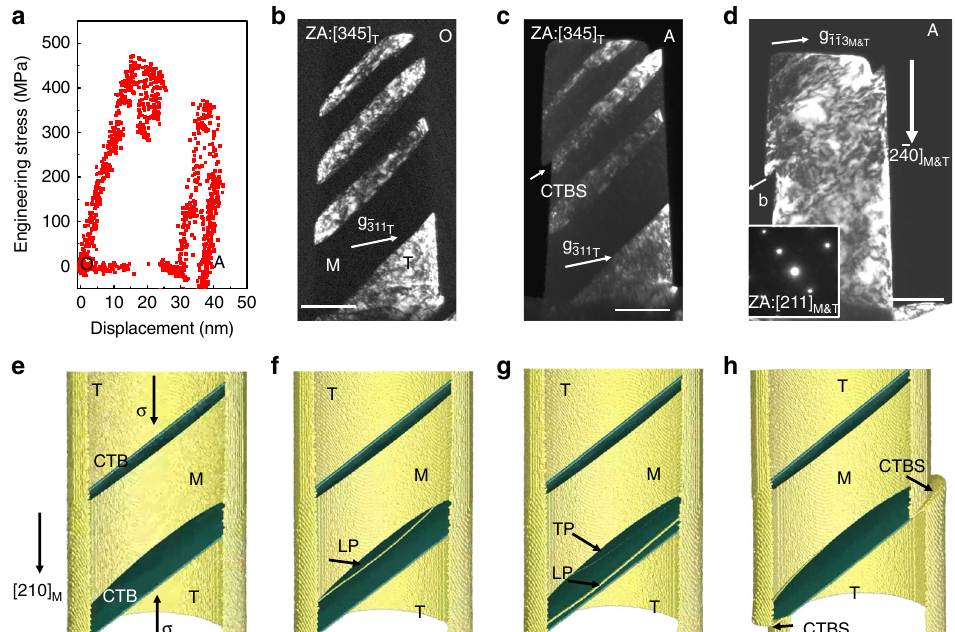
Fig. 3 Typical example of coherent twin boundary sliding. a Experimentally measured mechanical response of the nano-twinned single-crystal Cu nanopillar subjected to compression along ½ 120 (cid:2) orientation. The plot shows engineering stress as a function of loading displacement. Images b to d show M&T dark- fi eld TEM images of nano-twinned Cu compressed inside the TEM. Dark- fi eld TEM image of Cu pillar b before and c after compression under [345] T beam direction, and d after compression under [211] beam direction. The inset denotes the selected-area diffraction pattern. e – h show the evolution of coherent twin boundary sliding (CTBS) as predicted by the MD simulation. e A ½ 210 (cid:2) orientated Cu pillar (an equivalent orientation to ½ 120 (cid:2) ) M created by MD simulation before tension. f A leading partial dislocation is nucleated and it propagates coherent twin boundary (CTB). g A trailing partial dislocation is nucleated and it propagates CTB. h A large surface step arising from coherent twin boundary sliding (CTBS). The scale bars in b , c , d represent 100